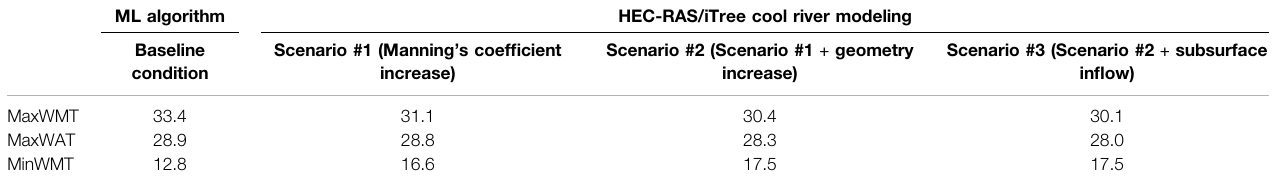
TABLE 2 | Average thermal metrics of the river temperature ( ° C) in the downstream control station #4D for the baseline condition and under the alternative scenarios during the migration season (February 1 – May 31, 2016). ML